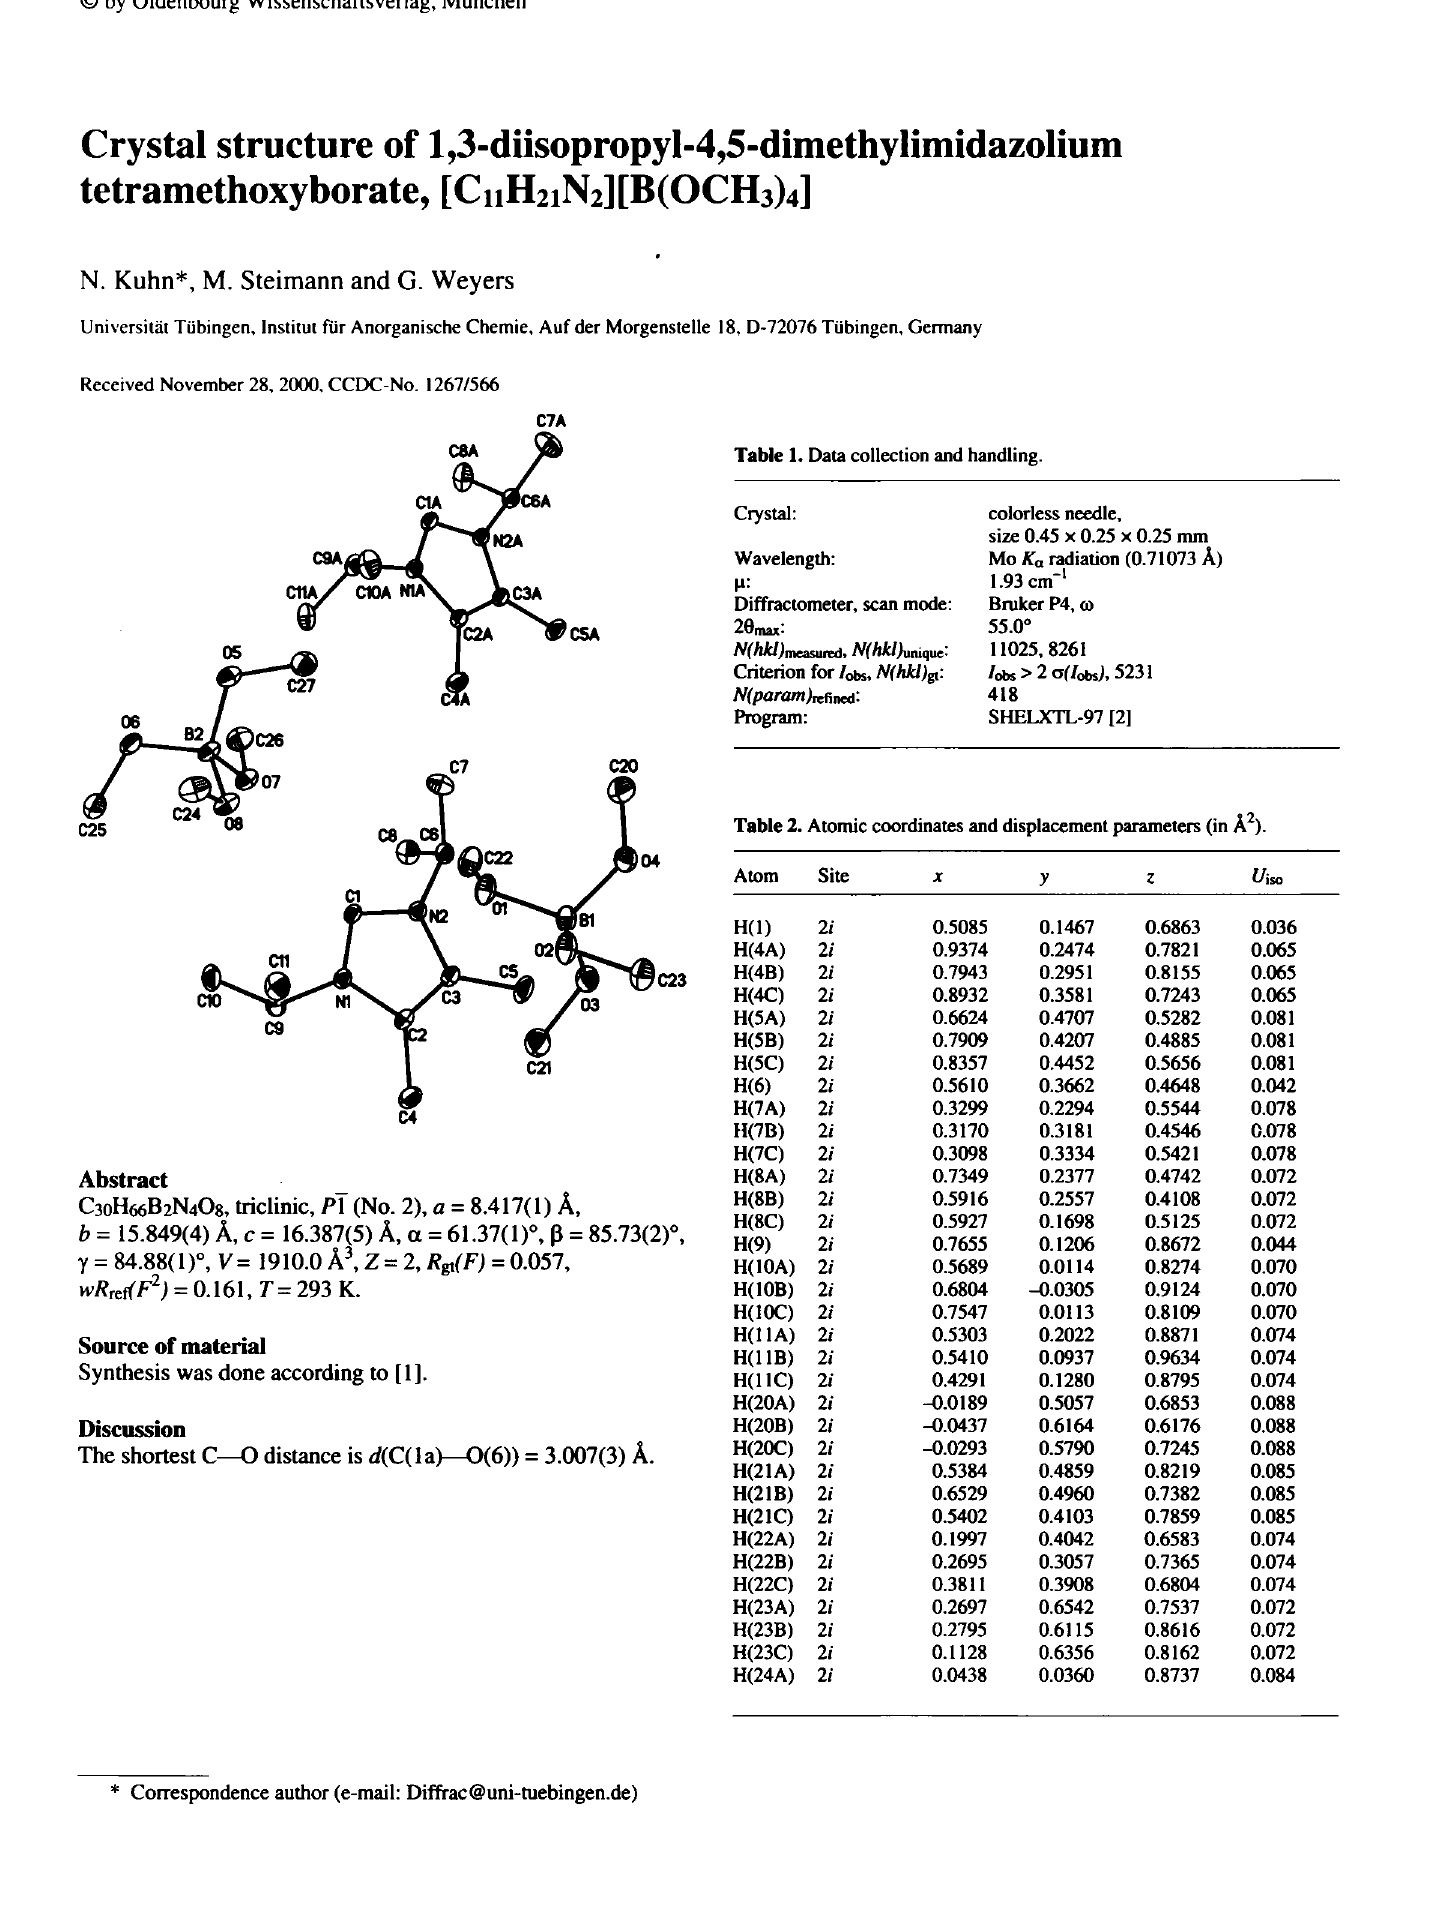
Table 1. Data collection and handling.